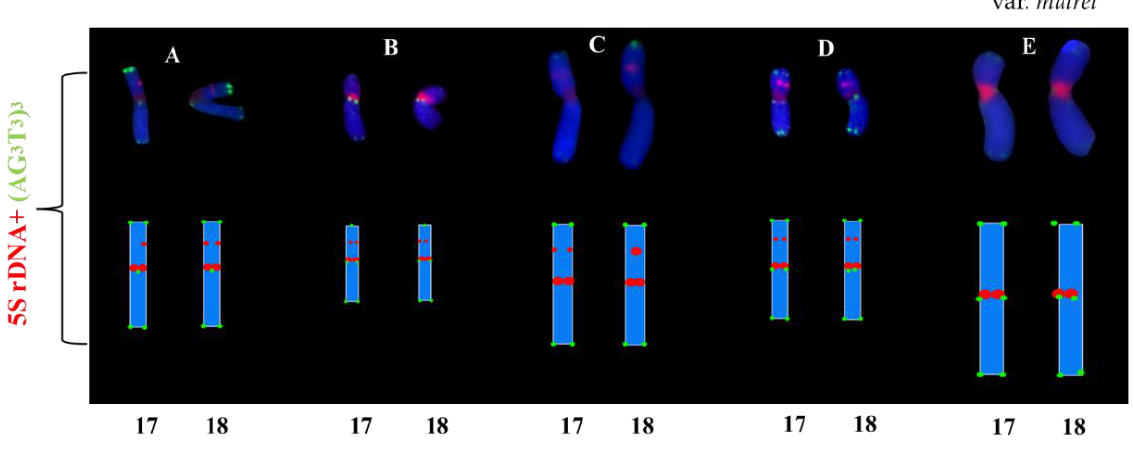
Figure 5. Signal distribution of the five Taxus species. ( A ) T. wallichiana , ( B ) T. × media , ( C ) T. yunnanensis , ( D ) T. cuspidate, and ( E ) T. wallichiana var. mairei. The idiograms were constructed based on the signal patterns of the chromosomes mentioned above and the chromosomes in Figure 1. The numbers at the bottom represent the number of chromosomes.